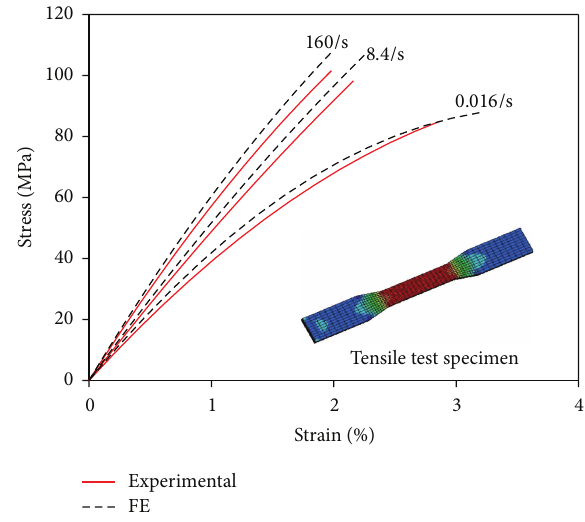
Figure 1: FE validation of windshield material model.